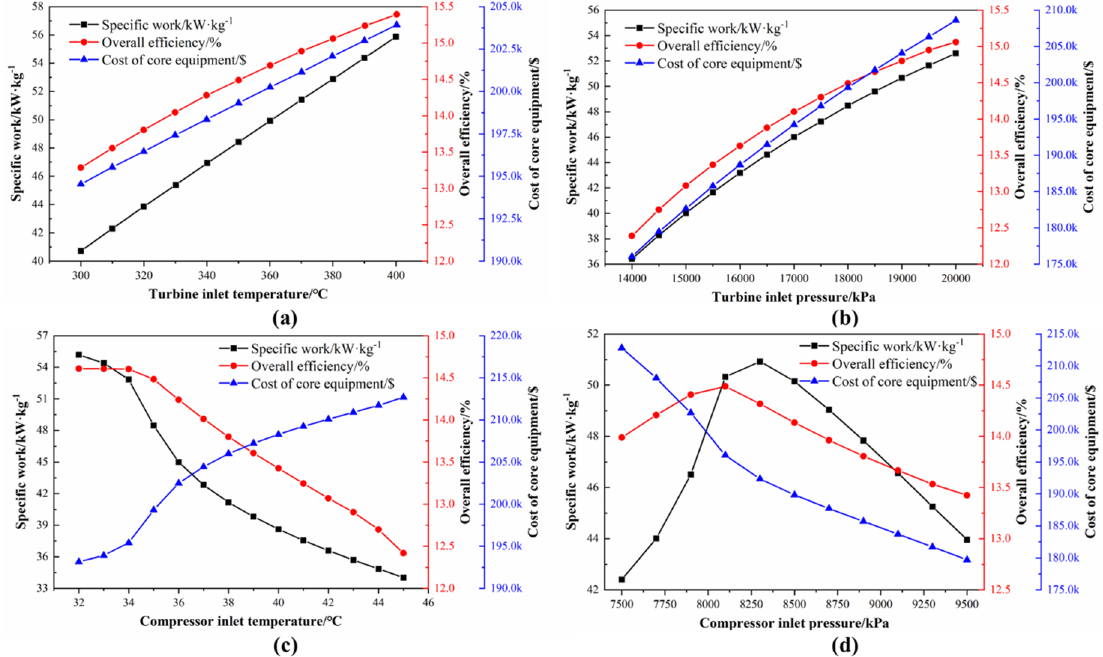
Figure 7. Effects of the turbine inlet temperature ( a ), turbine inlet pressure ( b ), compressor inlet temperature ( c ), and compressor inlet pressure ( d ) on specific work, overall efficiency, and cost of core equipment (simple recuperated cycle).